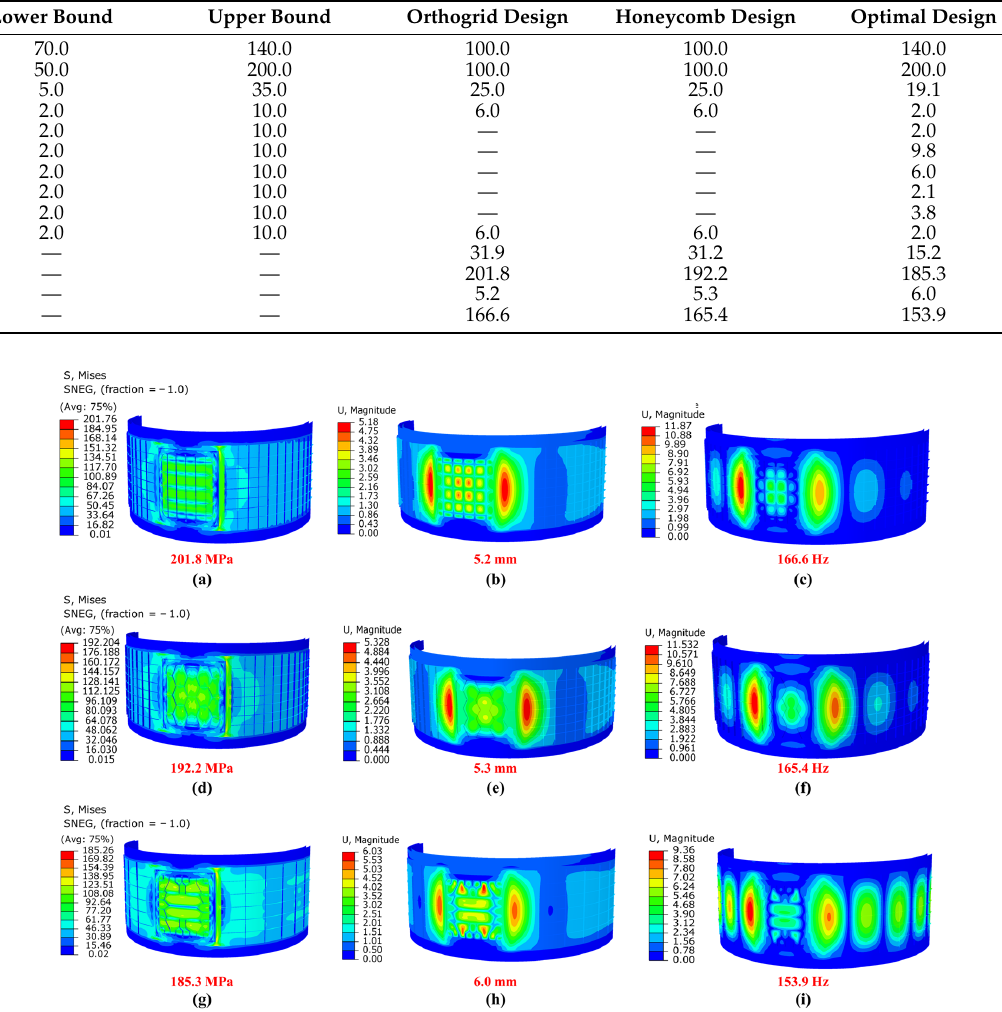
Figure 10. Comparison of the finite element analysis results between initial and optimal design of the overall model. (a) Mises stress field of the overall model in orthogrid design. (b) Displacement field of the overall model in orthogrid design. (c) First order modal shape of the overall model in orthogrid design. (d) Mises stress field of the overall model in honeycomb design. (e) Displacement field of the overall model in honeycomb design. (f) First order modal shape of the overall model in honeycomb design. (g) Mises stress field of the overall model in optimal design. (h) Displacement field of the overall model in optimal design. (i) First order modal shape of the coverall model in optimal design.